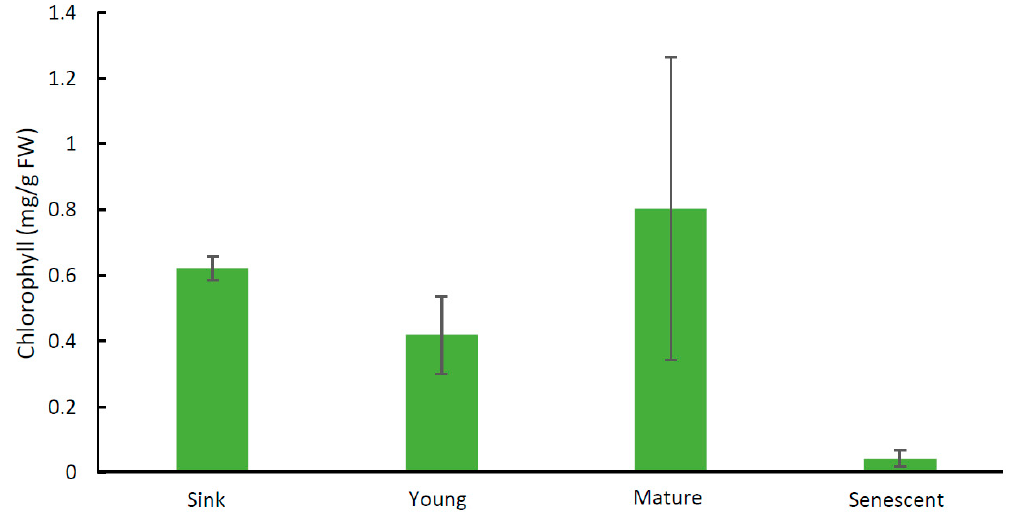
Figure 1. Chlorophyll content of leaves of Pisum sativum . Expanding sink leaves (sink), source leaves subtending pods five days after flowering (young) and 20 days after flowering (mature), and senescing leaves were analysed. Data are the averages of two biological replicates, with three replicate extractions for each sample. Results are ± s.d.